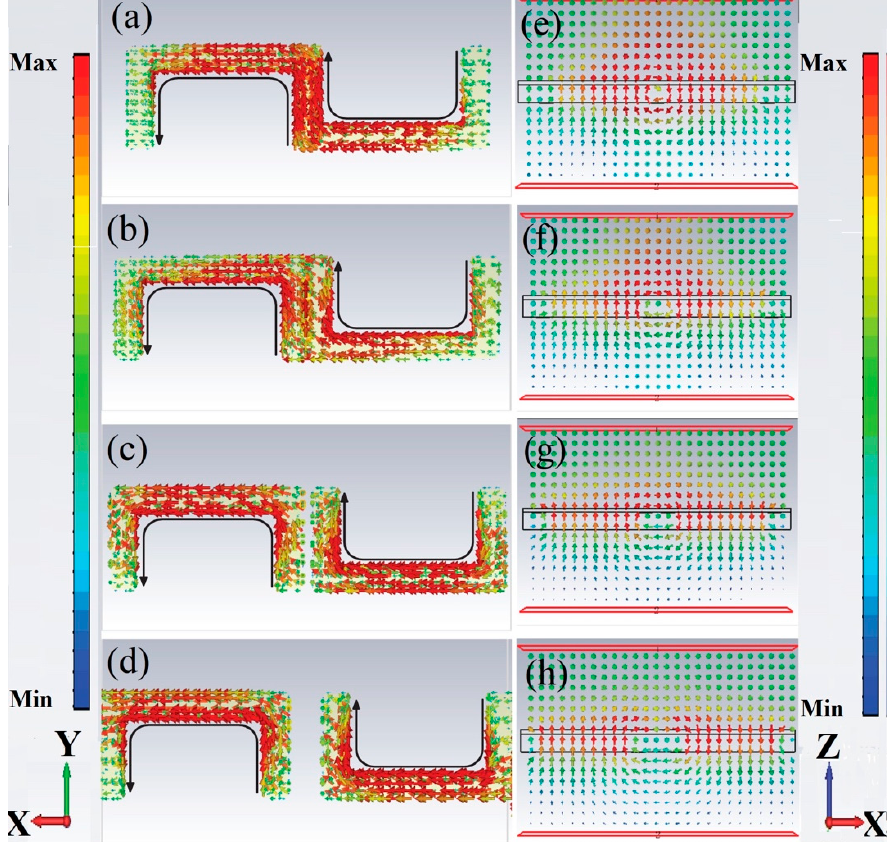
Figure 3. Simulated surface currents ( a – d ) and magnetic field (on the XZ plane at Y = 0 ( e – h ) of resonator at low frequency resonances.